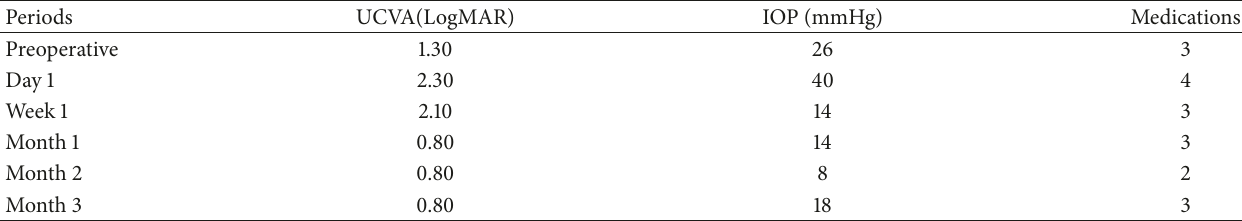
Table 1: Monitoring of Visual acuity, intraocular pressure and number of